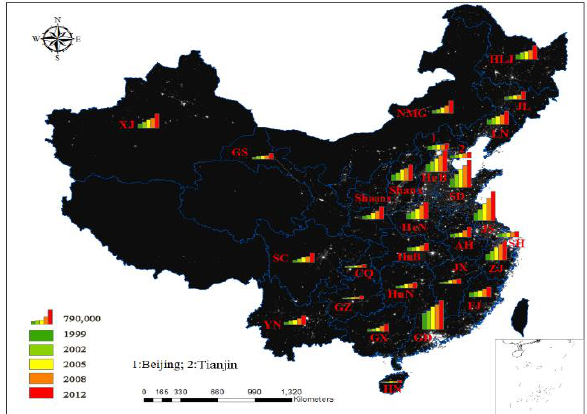
Figure 3. Spatiotemporal distribution of DN in China